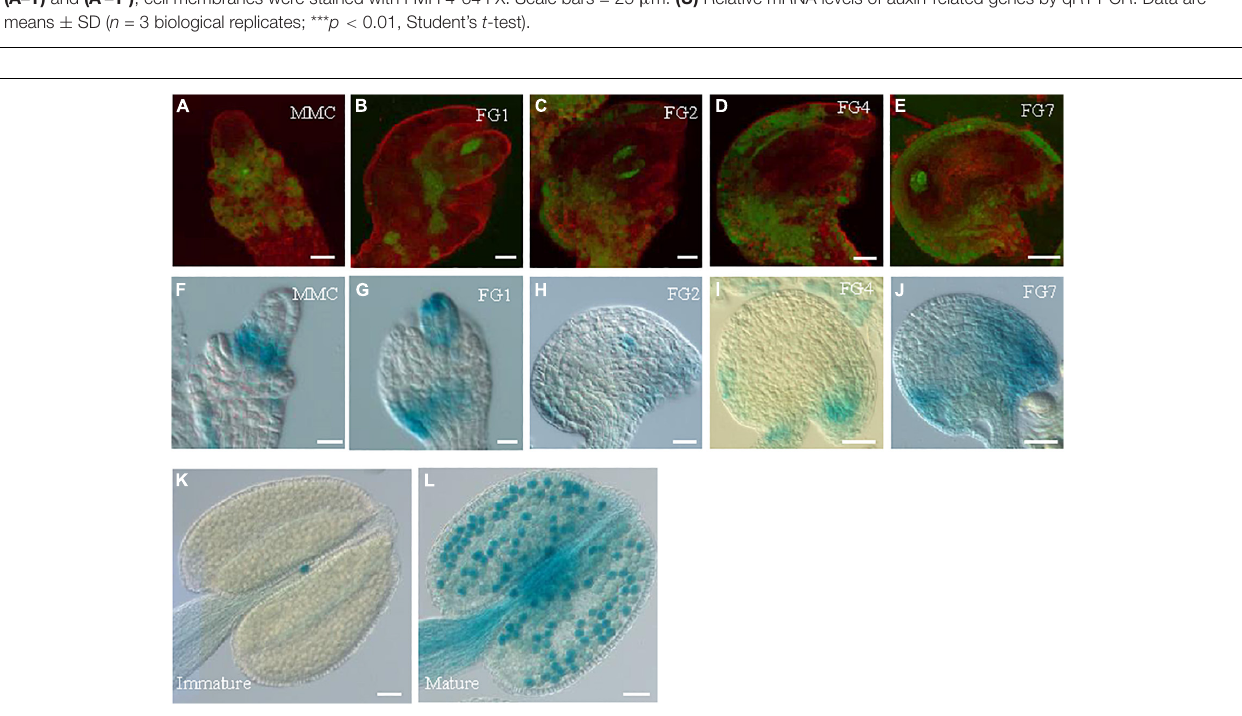
FIGURE 8 | The expression profiles of GRDP1 in Arabidopsis. (A–E) pGRDP1:GFP expression pattern in different ovule development stages. The developmental stages of the ovules are indicated at the top right corner of each panel. Bars = 20 µ m. (F–J) pGRDP1:GUS expression pattern in ovules. Bars = 20 µ m. (K,L) pGRDP1:GUS expression pattern in pollen. Bars = 50 µ